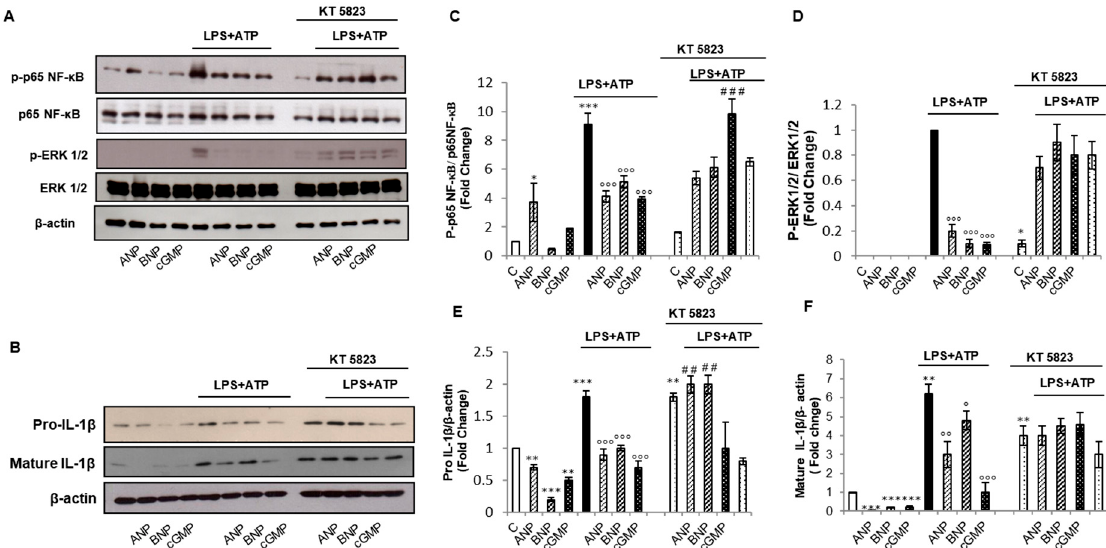
Figure 2. cGMP/PKG-I axis is involved in the priming mechanism controlling IL-1 β production . THP-1 cells were pre-treated for 10 min with ANP (10 − 8 M) or BNP (10 − 8 M) or cGMP (100 μ M 8-Br-cGMP) in the absence or presence of LPS (10 μ g/mL for 20 min) + ATP (5 mM for 40 min). When KT-5823 (1 μ M) was used, it was added 1 h before ANP, BNP, or 8-Br-cGMP treatment. Cell lysates were immunoblotted for p-p65-NF- κ B and total p65-NF- κ B, p-ERK 1/2 and total ERK1/2 ( A ) or pro- and mature-IL-1 β ( B ). Protein loading was assessed by re-probing the blots with an anti- β -actin antibody. Representative western blots images are shown. ( C – F ) Histograms of densitometric quantification. Bars represent the ratio between phosphorylated and total protein band intensity. Untreated cells were used as control and assumed as 1. When no band appears in control cells, LPS + ATP was assumed as 1. All histograms indicate the mean ± SD of at least n = three independent experiments, each one tested in triplicate. * p < 0.05, ** p < 0.01, *** p < 0.001 versus untreated cells; ◦ p < 0.05, ◦◦ p < 0.01, ◦◦◦ p < 0.001 versus LPS + ATP treated cells; ## p < 0.01, ### p < 0.001 versus KT-5823 + LPS + ATP treated cells.